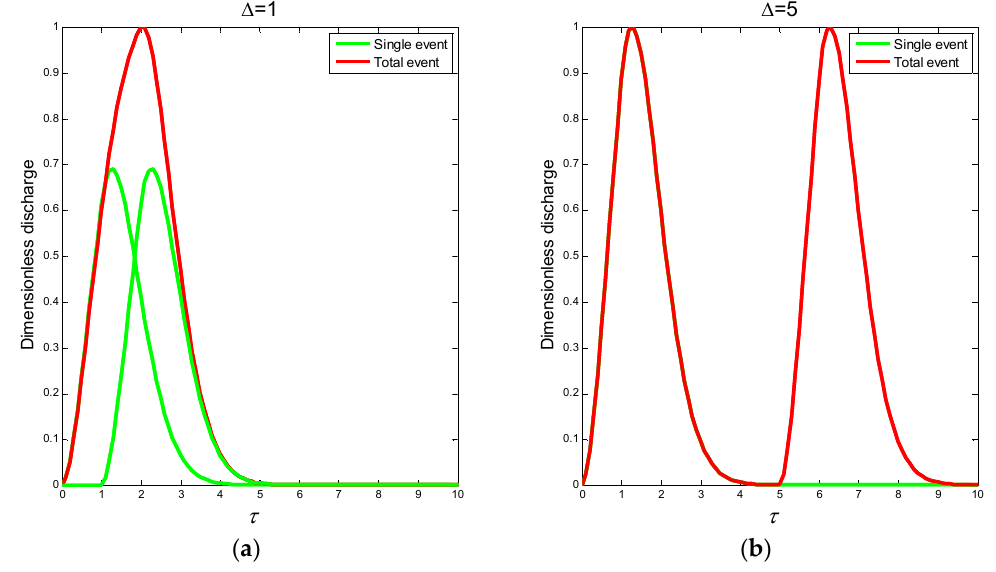
Figure 3. Flood hydrographs considering the variable temporal distance between the flood peaks, using the spillway DC α = 4 and the SC β = 4: ( a ) time shift between the two peaks ( Δ ) equal to 1; ( b ) time shift between the two peaks ( Δ ) equal to 5.